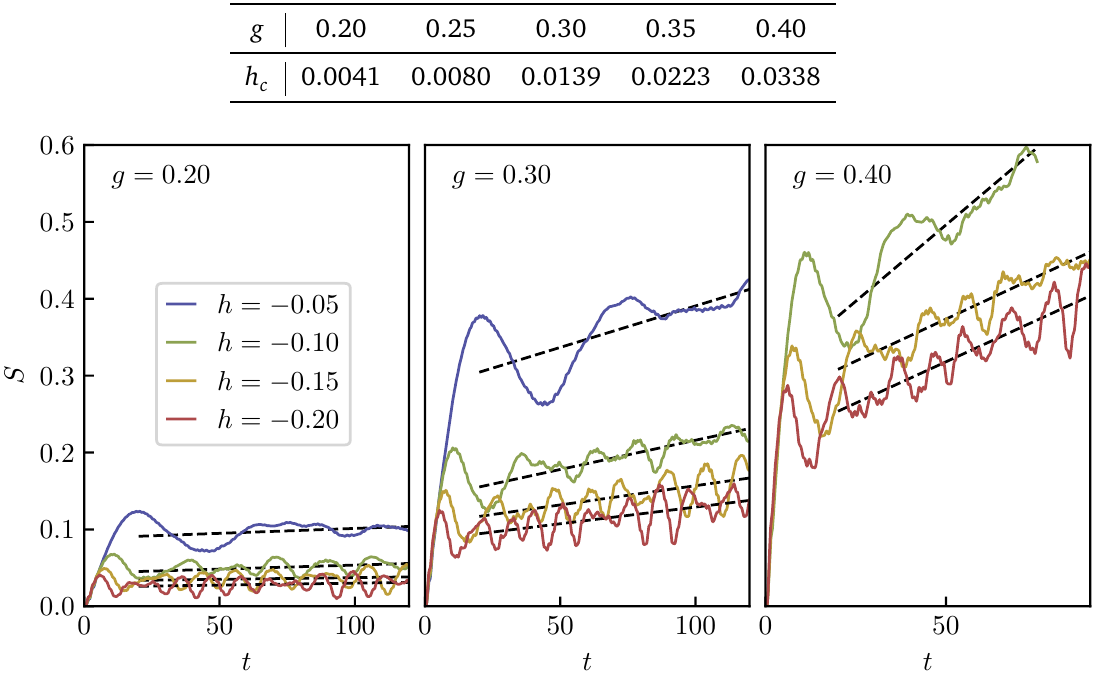
for different values of g . c